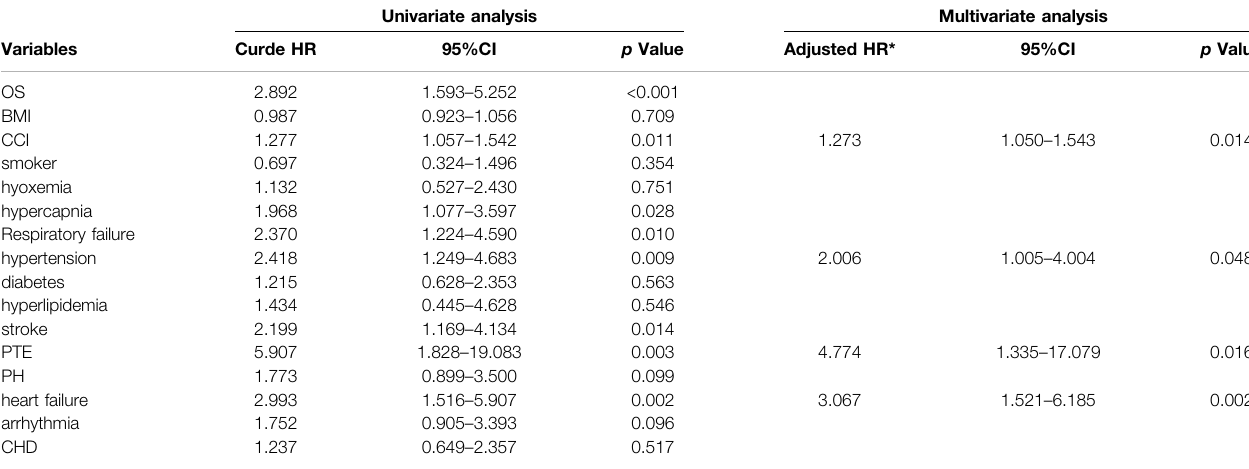
TABLE 5 | Results of univariate and multivariate Cox regression